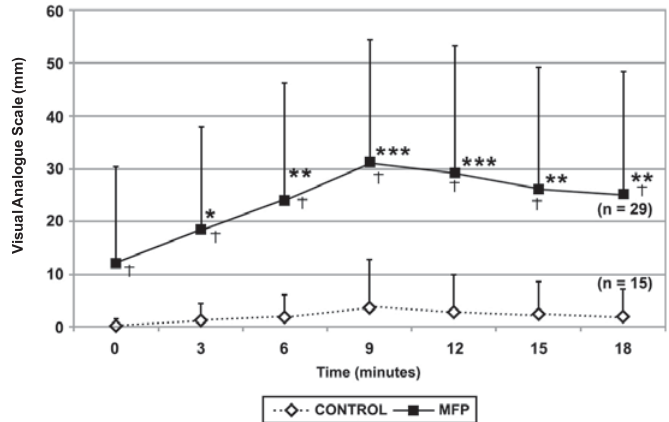
Figure 1- Pain intensity during the chewing test of patients with myofascial pain (MFP) and control subjects. * the same (cid:2)(cid:3)(cid:4)(cid:5)(cid:6)(cid:7)(cid:8)(cid:9)(cid:10)(cid:8)(cid:11)(cid:12)(cid:13)(cid:6)(cid:7)(cid:14)(cid:12)(cid:15)(cid:12)(cid:8)(cid:14)(cid:2)(cid:16)(cid:14)(cid:17)(cid:11)(cid:13)(cid:6)(cid:12)(cid:8)(cid:2)(cid:9)(cid:8)(cid:12)(cid:13)(cid:11)(cid:13)(cid:14)(cid:12)(cid:13)(cid:14)(cid:17)(cid:11)(cid:18)(cid:18)(cid:19)(cid:8)(cid:12)(cid:14)(cid:20)(cid:2)(cid:14)(cid:21)(cid:17)(cid:11)(cid:2)(cid:13)(cid:8)(cid:16)(cid:14)(cid:10)(cid:10)(cid:6)(cid:7)(cid:6)(cid:2)(cid:17)(cid:6)(cid:12)(cid:8)(cid:22)(cid:23)(cid:24)(cid:25)(cid:26)(cid:25)(cid:27)(cid:28)(cid:8)(cid:22)(cid:14)(cid:2)(cid:13)(cid:7)(cid:11)(cid:20)(cid:7)(cid:9)(cid:3)(cid:23)(cid:8)(cid:11)(cid:2)(cid:11)(cid:18)(cid:19)(cid:12)(cid:14)(cid:12)(cid:28)(cid:26)(cid:8)(cid:29)(cid:8)(cid:12)(cid:14)(cid:20)(cid:2)(cid:14)(cid:21)(cid:17)(cid:11)(cid:2)(cid:13)(cid:8)(cid:16)(cid:14)(cid:10)(cid:10)(cid:6)(cid:7)(cid:6)(cid:2)(cid:17)(cid:6)(cid:12)(cid:8) between groups at the same intervals time (intergroup